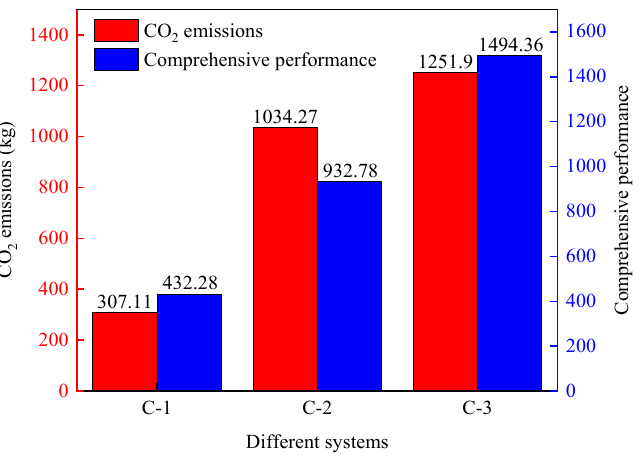
Figure 12. Comparison of CO 2 emissions and comprehensive performance of different systems.